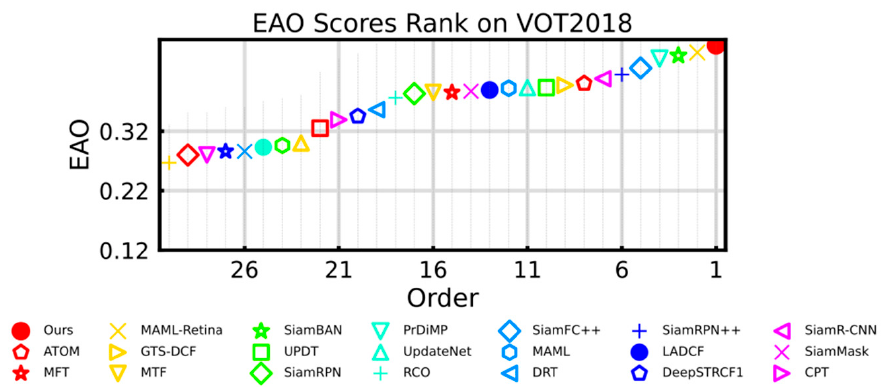
Figure 6. EAO ranking of the evaluated tracker on VOT2018 benchmark. Table 2. Performance comparisons on VOT2018 benchmark.